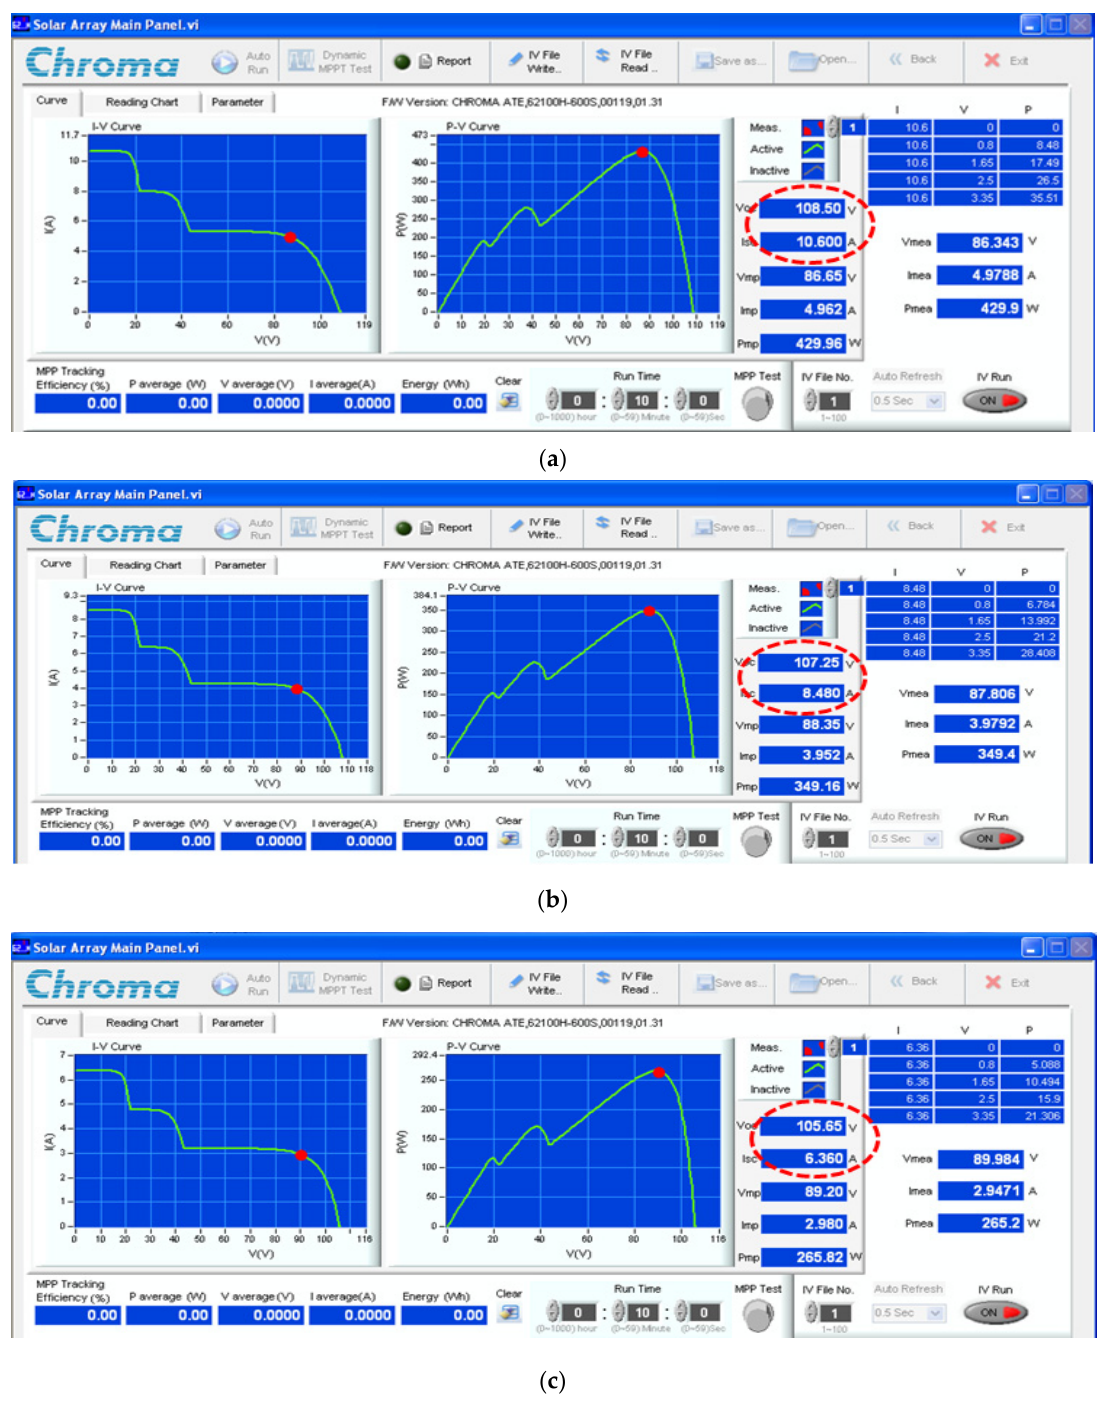
Figure 22. P ‐ V and I ‐ V curves under PSC for irradiations of ( a ) 1000 W/m 2 ; ( b ) 800 W/m 2 and Figure 22. P-V and I-V curves under PSC for irradiations of ( a ) 1000 W/m 2 ; ( b ) 800 W/m 2 and ( c ) 600 W/m 2 . ( c ) 600 W/m 2